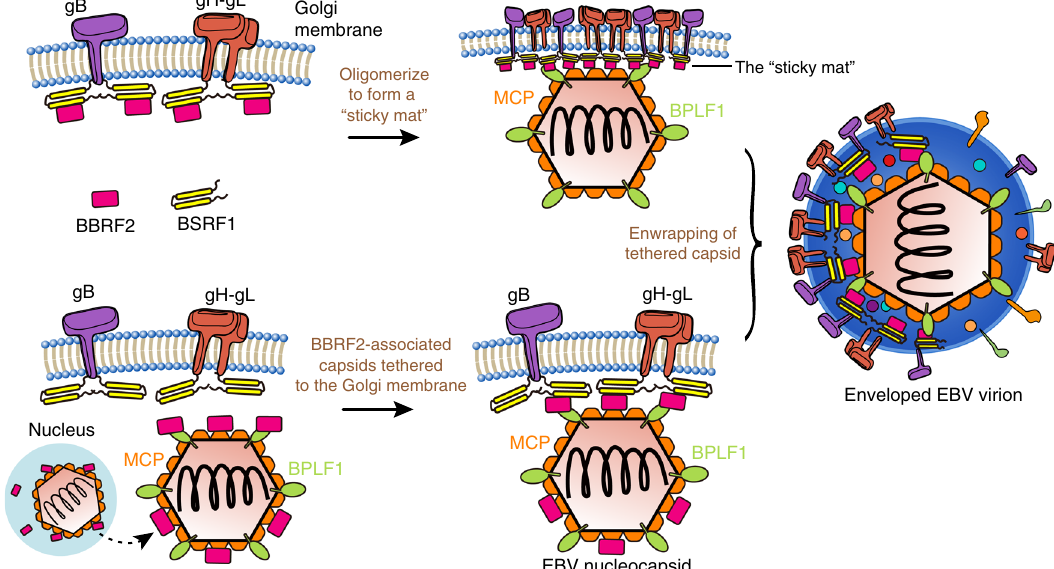
Fig. 8 Model of BBRF2-BSRF1 complex-mediated EBV secondary envelopment. Proposed working model for the BBRF2-BSRF1 complex during secondary envelopment of EBV. BSRF1 and BBRF2 form stable heterodimers at the cytoplasmic site of the Golgi apparatus, and are associated with glycoproteins. Next, the BBRF2-BSRF1 complexes oligomerize, creating a “ stick mat ” , which tethers EBV nucleocapsids to the Golgi apparatus and eventually facilitates the secondary envelopment process. Alternatively, the EBV capsid may bind BBRF2 in the cell nucleus prior to entering the cytoplasm. The BBRF2-associated capsid then binds Golgi-localized